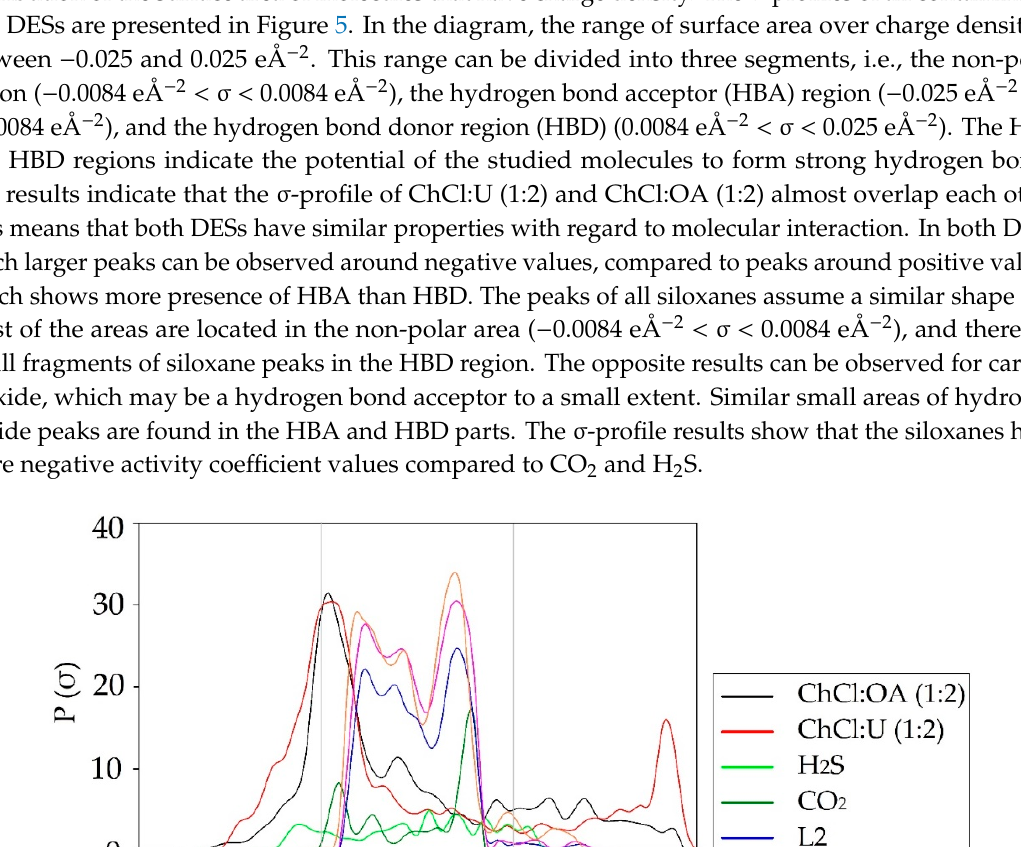
Figure 4. Optimized structures of ( a ) ChCl:OA (1:2), ( b ) ChCl:UA (1:2).